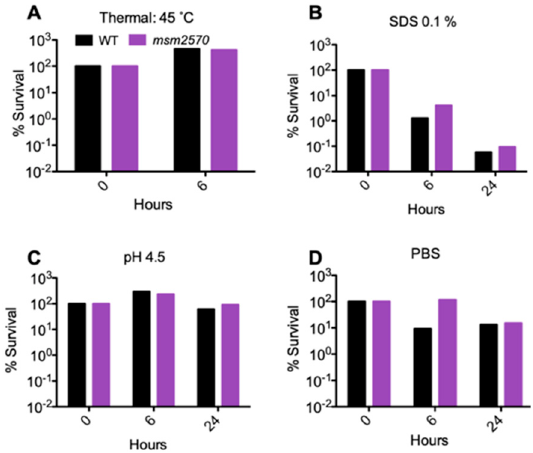
Figure 4. Sensitivity of the msm2570::Tn mutant and wild-type cells to thermal, SDS, pH, and PBS stresses. Percent survival of WT and the msm2570 mutant at 45 ◦ C ( A ), after incubation in 7H9 in the presence of 0.1% SDS ( B ), pH 4.5 ( C ), or PBS ( D